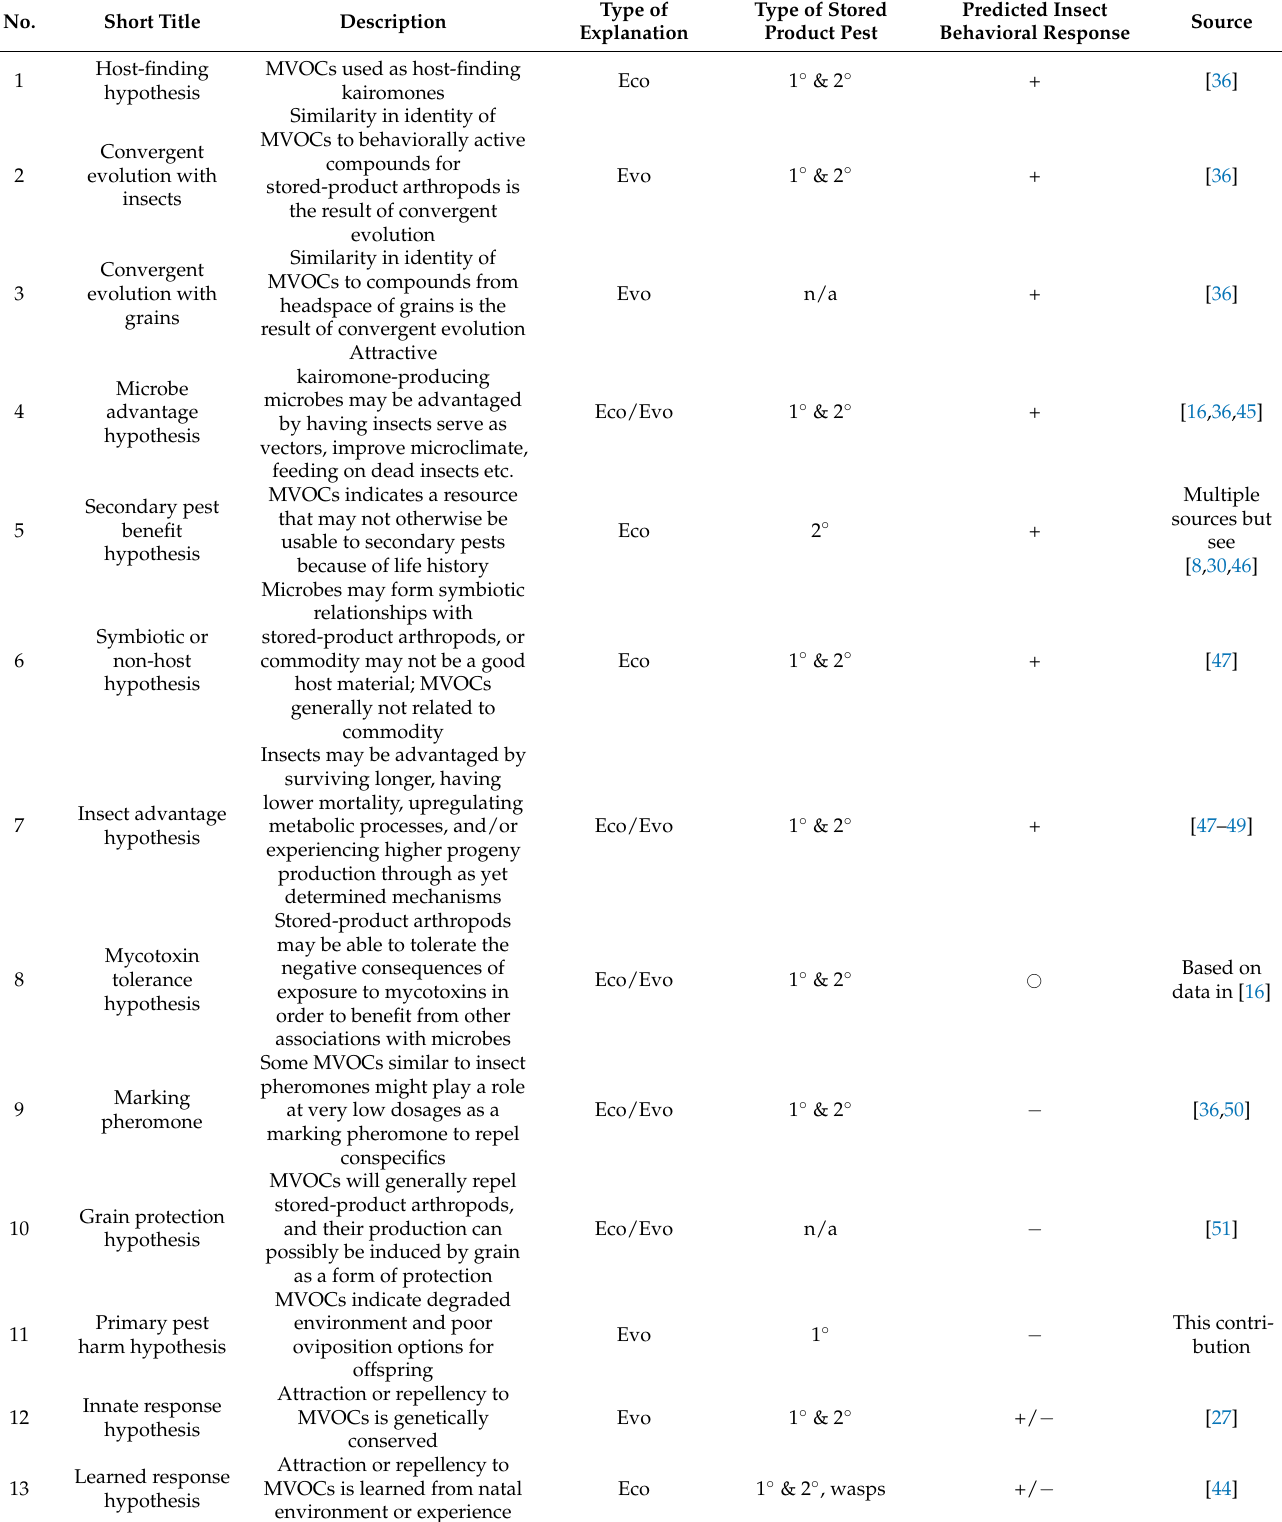
Table 5. Non-exhaustive and non-mutually exclusive hypotheses for the role of MVOCs in driving the behavior of stored-product arthropods described from the primary literature and in the current